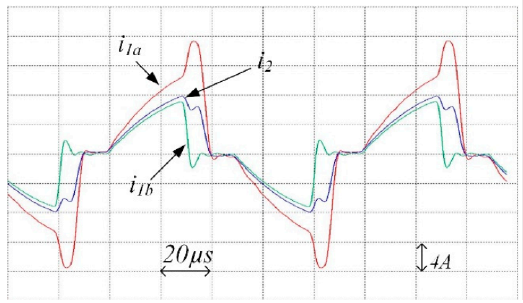
Figure 15. Currents through windings of the proposed system fed from PPSs emulating PV